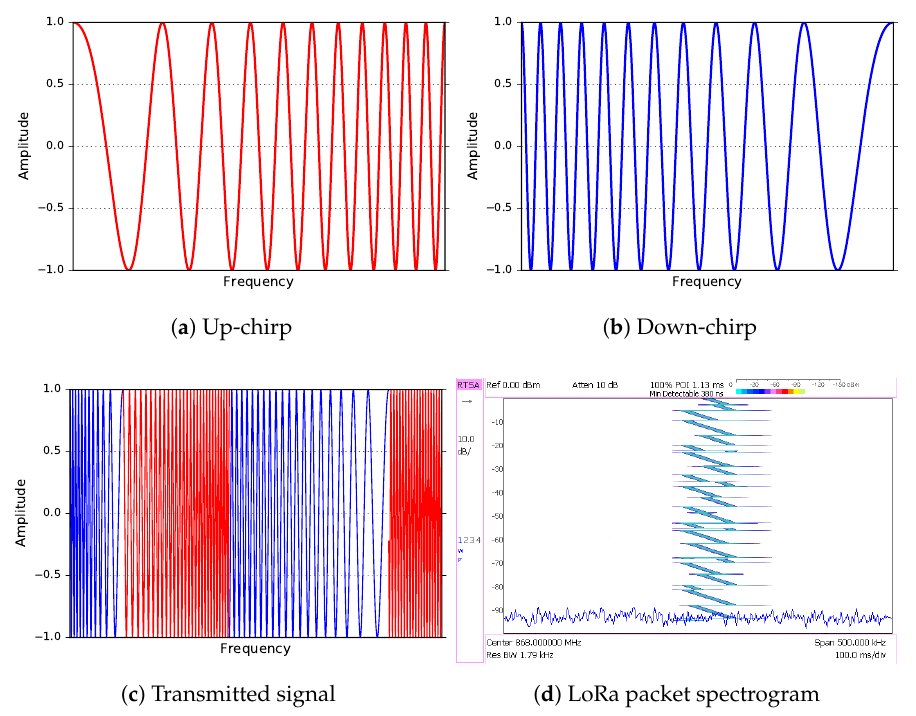
Figure 1. LoRa physical layer. Signals used to convey information: ( a ) up-chirp and ( b ) down-chirp; ( c ) transmitted signal composed of two up-chirps and two down-chirps; ( d ) LoRa packet spectrogram captured by real-time spectrum